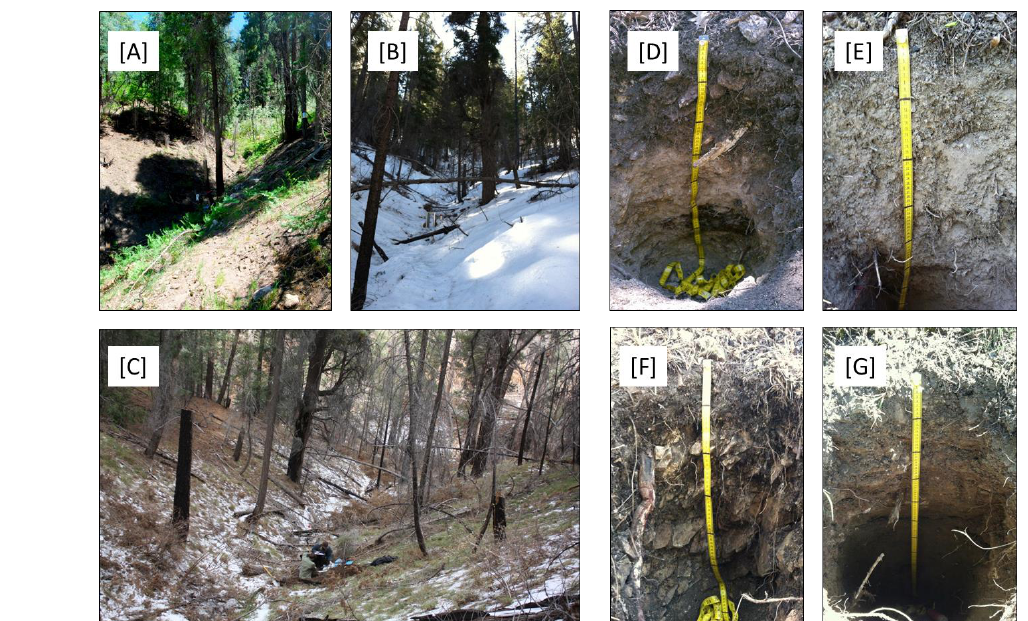
Figure 2. Study catchment seasonal cover and vegetation for (a) summer, (b) winter, and (c) early spring and typical soil profiles on (d) a granite hillslope, (e) granite divergent summit, (f) quartzite profile, and (g) amphibolite profile.